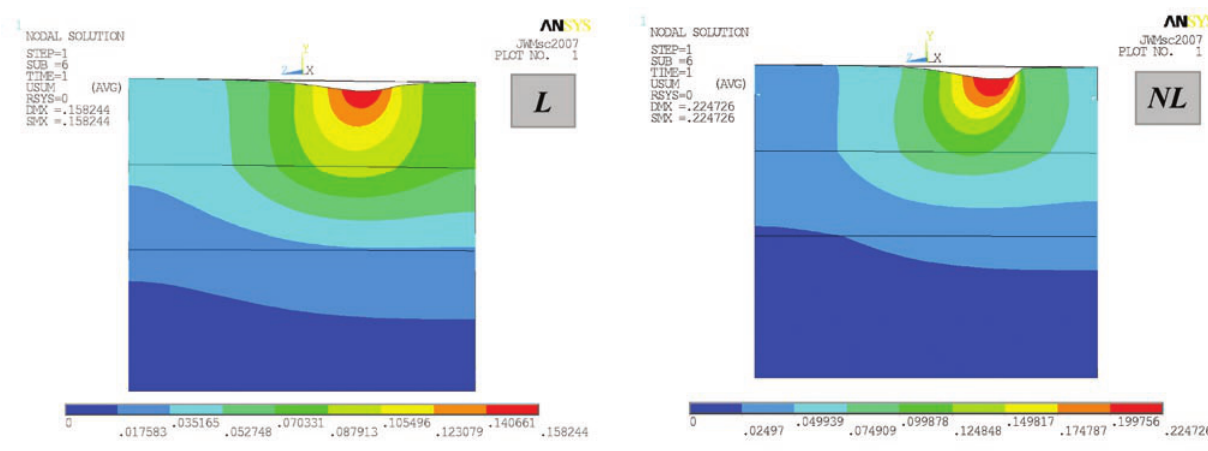
Fig. 9. Foundation settlements in the section per node of the max settlement s max , L = 0.158 m